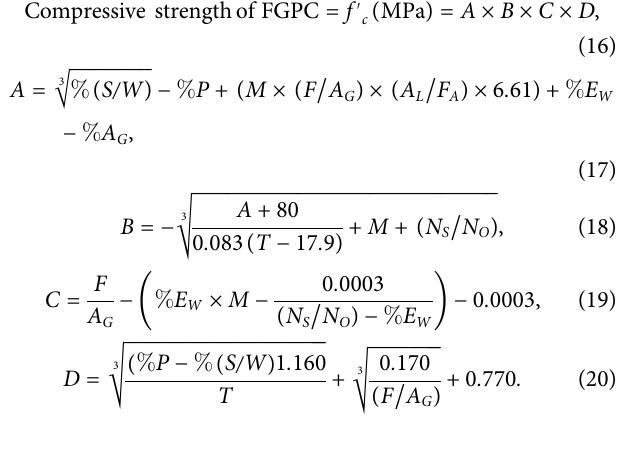
Frontiers in Materials |